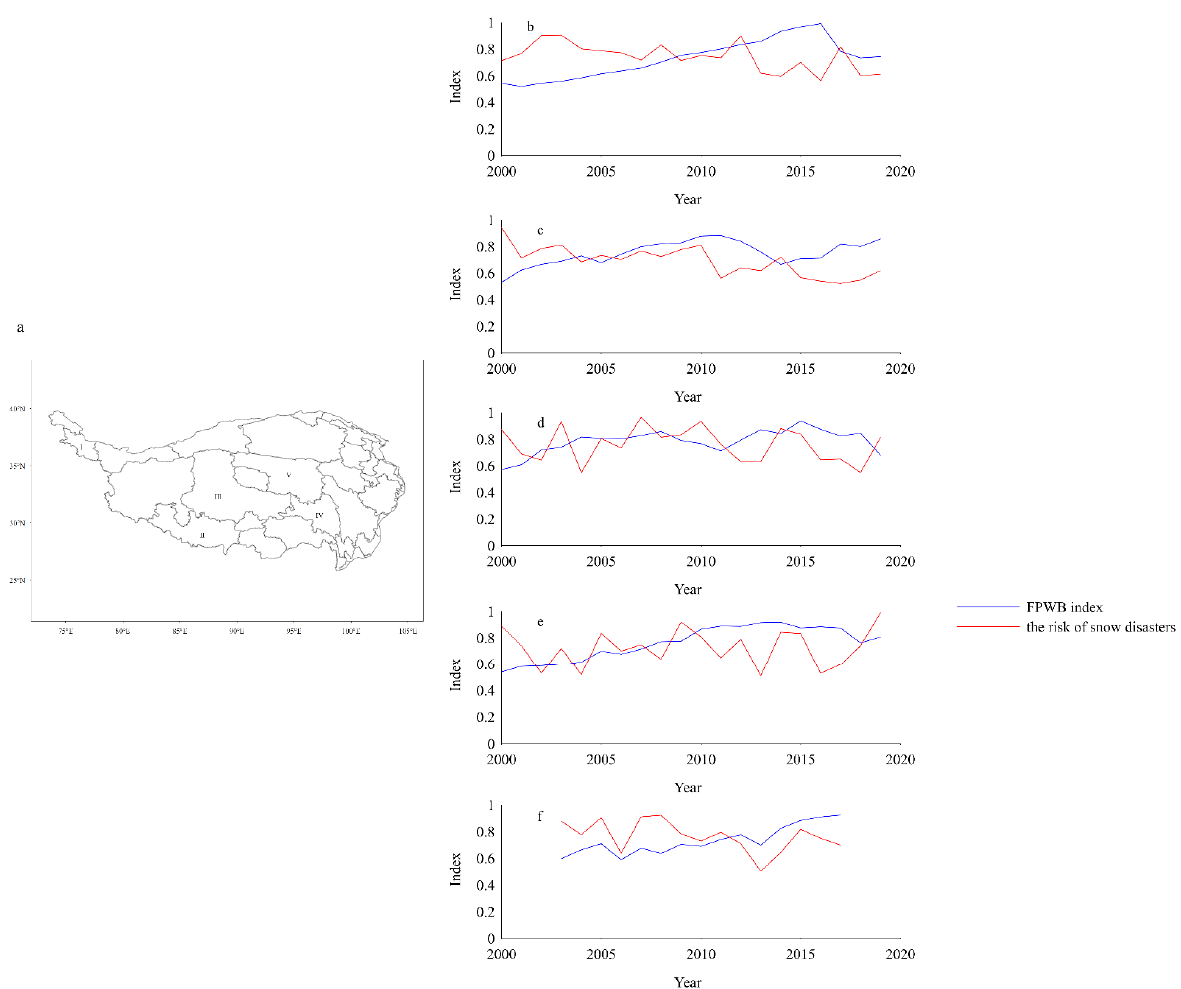
Figure 10. Typical regions ( a ) and variations of the FPWB index and the risk of snow disasters for every typical region (( b – f ) represent I, II, III, IV, and V, respectively). According to the method of calculation of the FPWB index, variations in the FPWB index in various typical regions from 2000 to 2019 were calculated (the period from 2003 to 2017 was used for Yushu due to problems encountered in data acquisition). Mean- while, the risk of hazard factors was used as the comprehensive assessment model for the severity of snow disasters. Variations in the risk of snow disasters of these typical regions in the same period were calculated, and the FPWB indices and variations of the risk of snow disasters are illustrated in Figure 10. From the long-term variation, the FPWB in these typical regions showed a significant ascending trend, which passed the significance test at the 0.01 level. The result indicates that the FPWB on the QTP has im- proved significantly since the 21st century, and the average growth rate of FPWB in the five typical regions is 3.6%, 1.9%, 2.8%, 1.3%, and 2.3%, respectively. The risk of snow disasters in regions I, II, and V exhibited a significant decreasing trend, while that in re- gions III and IV did not show significant variation. By using least-squares regression, the contribution of variations in the risk of snow disasters to the FPWB from 2000 to 2019 was quantitatively estimated (Table 5). The results suggest that the risk of snow disasters had an adverse effect on variations of the FPWB. Every 1% increase in the risk of snow disasters in several typical regions corresponded to 0.186%, 0.768%, 0.378%, 0.109%, and